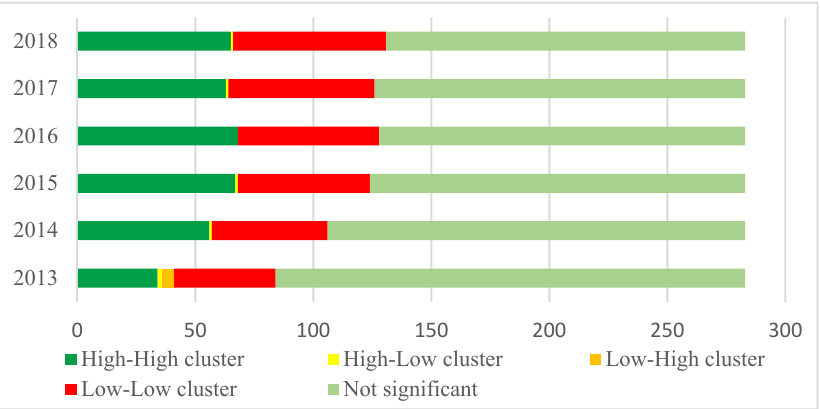
Figure 5. Statistics on the number of Local Moran’s I of cities from 2013 to 2018. According to the spatial-temporal evolution of urban human settlements from 2013 to 2018 (Figure 6), the spatial pattern remains unchanged as a whole, but some areas change between different years. Local spatial autocorrelation shows that the “cold spots” with low levels of human settlements are continuously distributed in the North China Plain in time and space, while the “hot spots” cities are continuously distributed in Southern China. Due to the natural factors, a large number of High-High agglomeration cities have been distributed in the Guangdong, Guangxi, Zhejiang, Fujian, and Yunnan provinces, and scattered into a whole. Due to the low urban economy and population density and less energy consumption, Heilongjiang has a low score in human settlements where human factors affect urban air quality. Because of the guidance of policy and the improve- ment of environmental protection awareness, the agglomeration of High-High cities is becoming increasingly obvious and the number of cities is also increasing. At the same time, Low-Low cities are also gradually increasing, spreading from Beijing, Tianjin, Hebei,